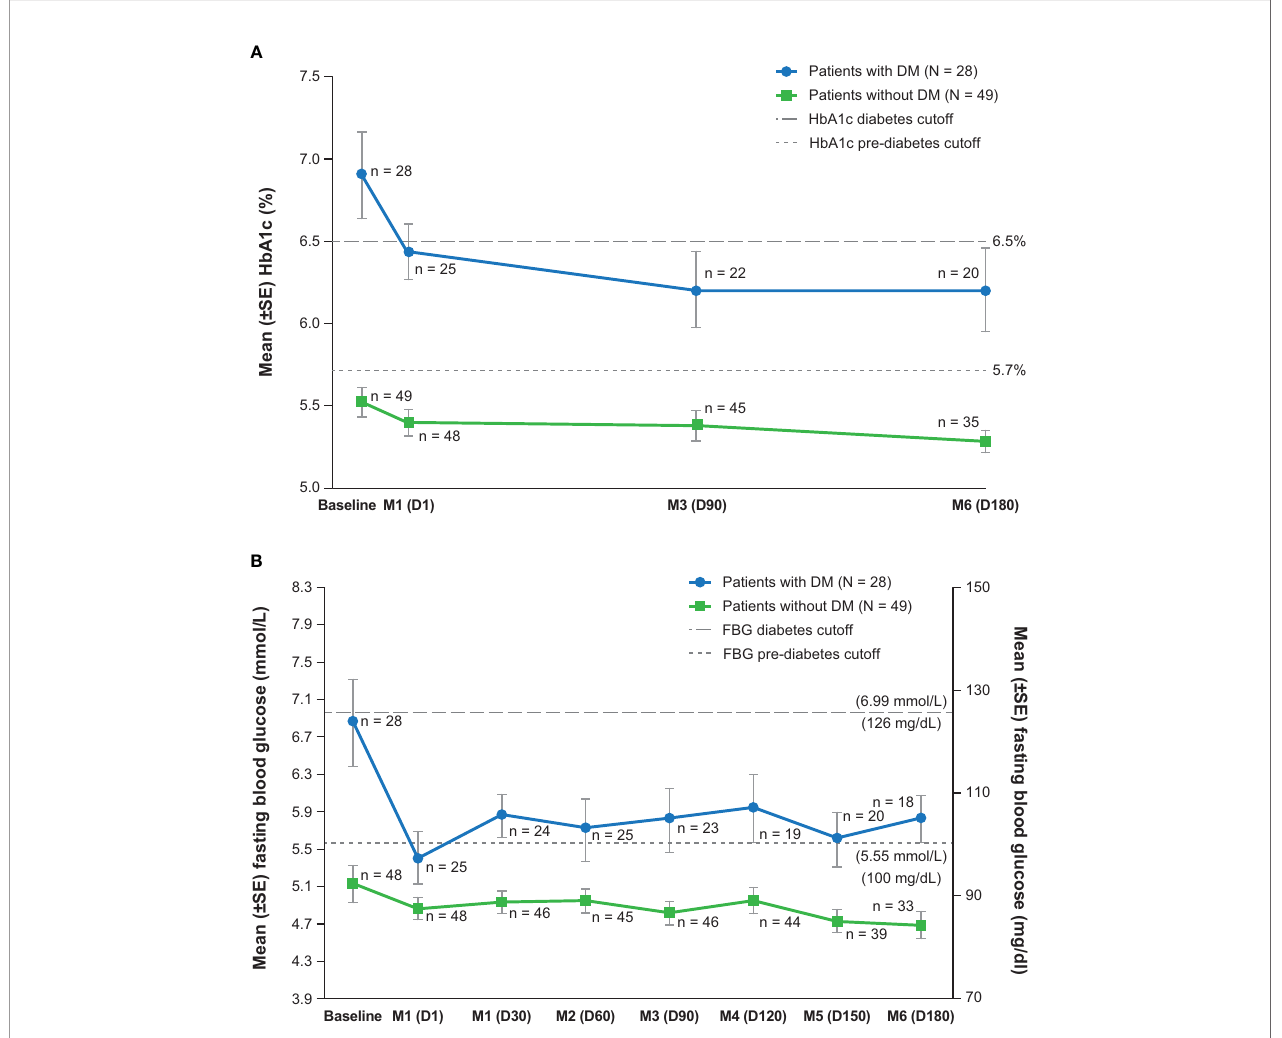
FIGURE 2 | Measures of glycemic control over time, (A) hemoglobin A1c and (B) fasting blood glucose (maintenance population). D, day; DM, diabetes mellitus; FBG, fasting blood glucose; HbA1c, hemoglobin A1c; M, month; SE, standard